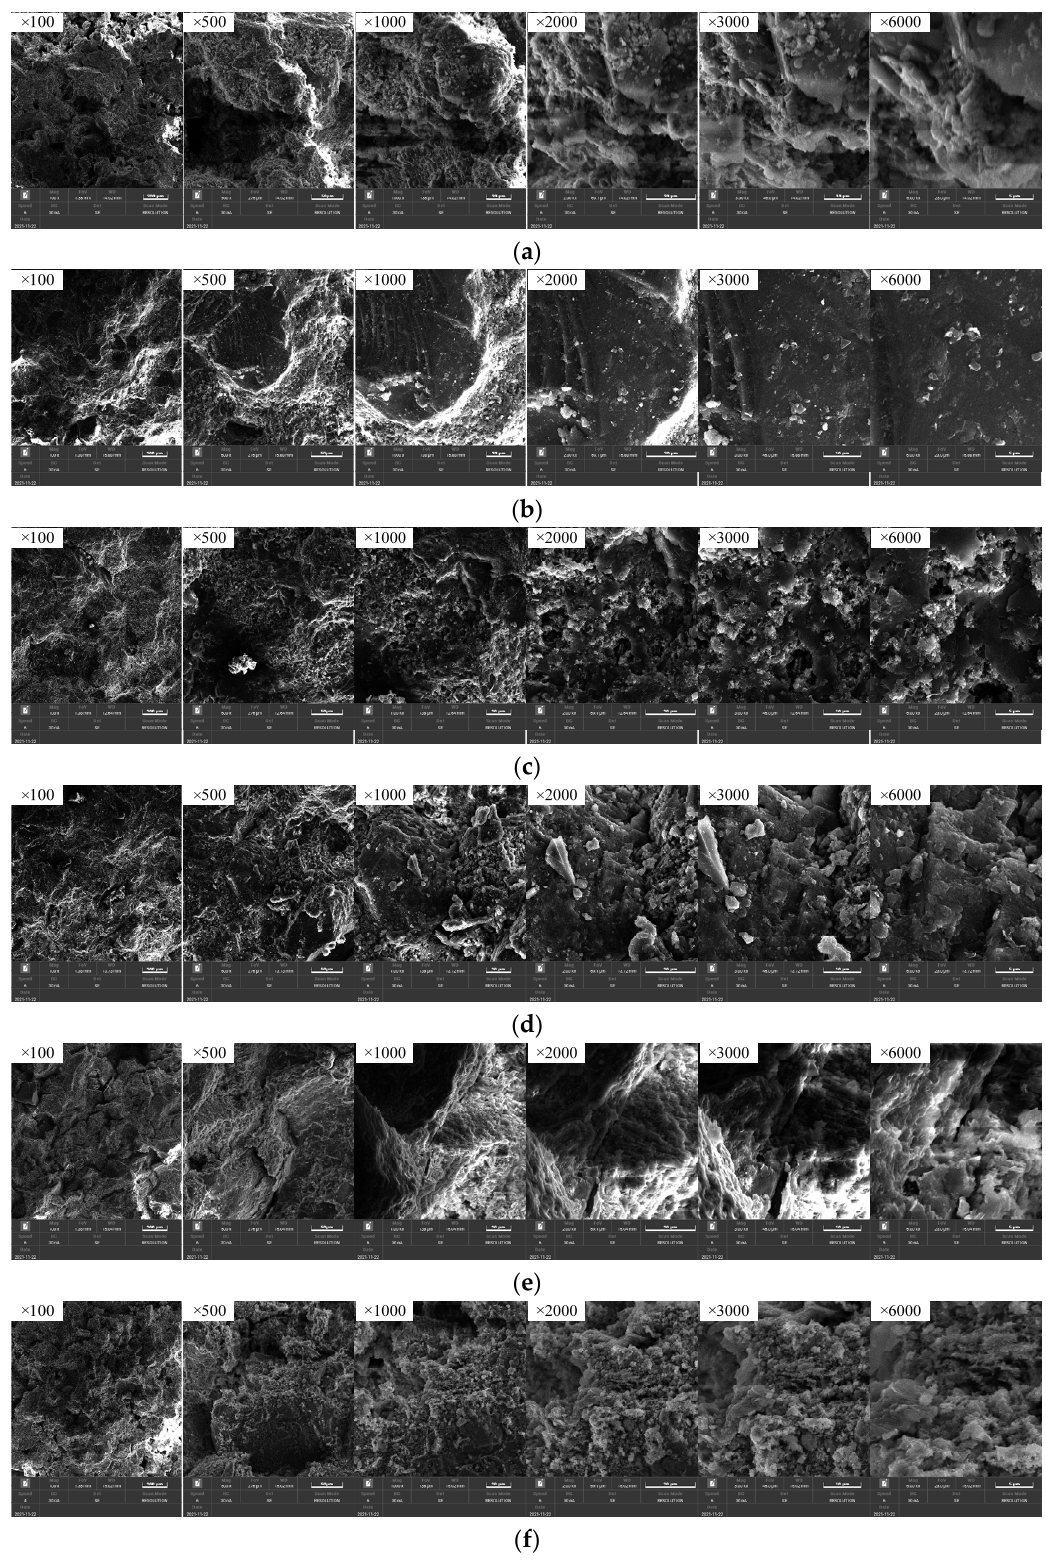
Figure 8. SEM images of sandstone after different high temperatures. ( a ) RT; ( b ) 200 °C; ( c ) 400 °C; ( d ) 600 °C; ( e ) 800 °C; ( f ) 1000 °C.